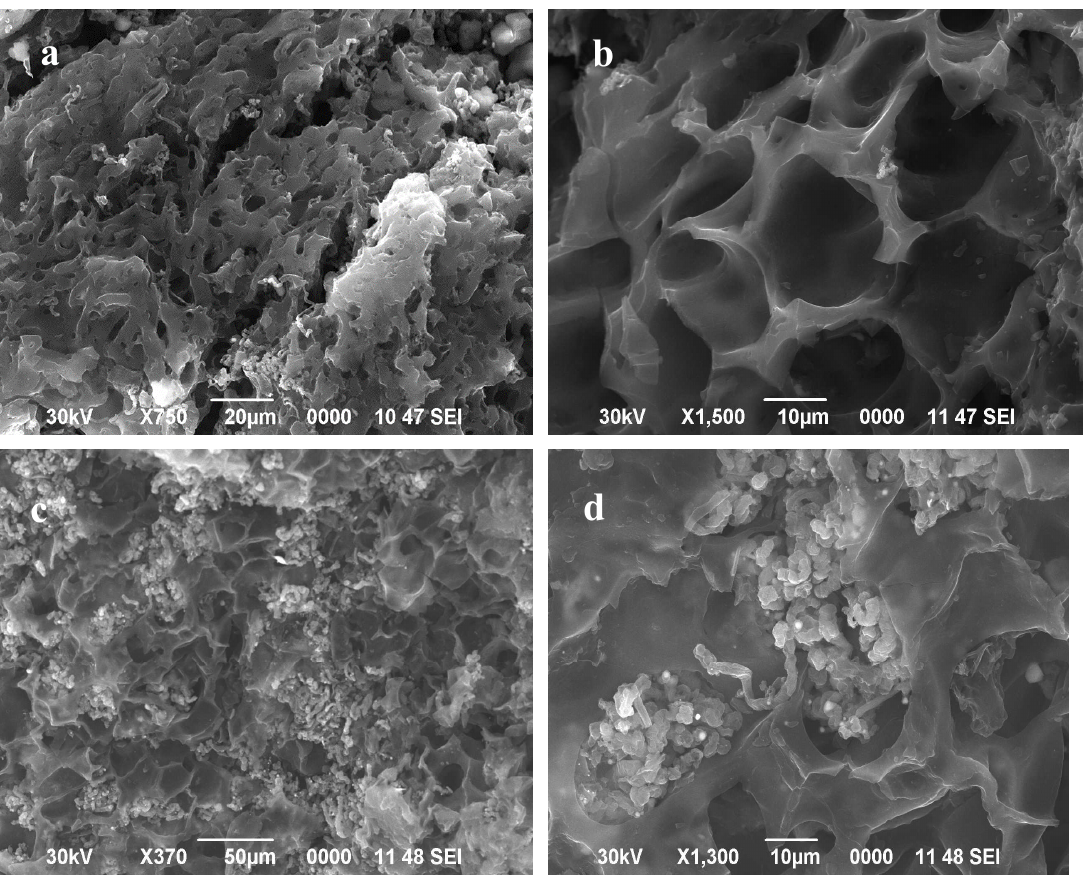
Figure 3. ( a , b ) SEM micro-images of ARH. ( c , d ) SEM micro-images of ARH after modification with 9 wt.% Ni(OH) 2 .